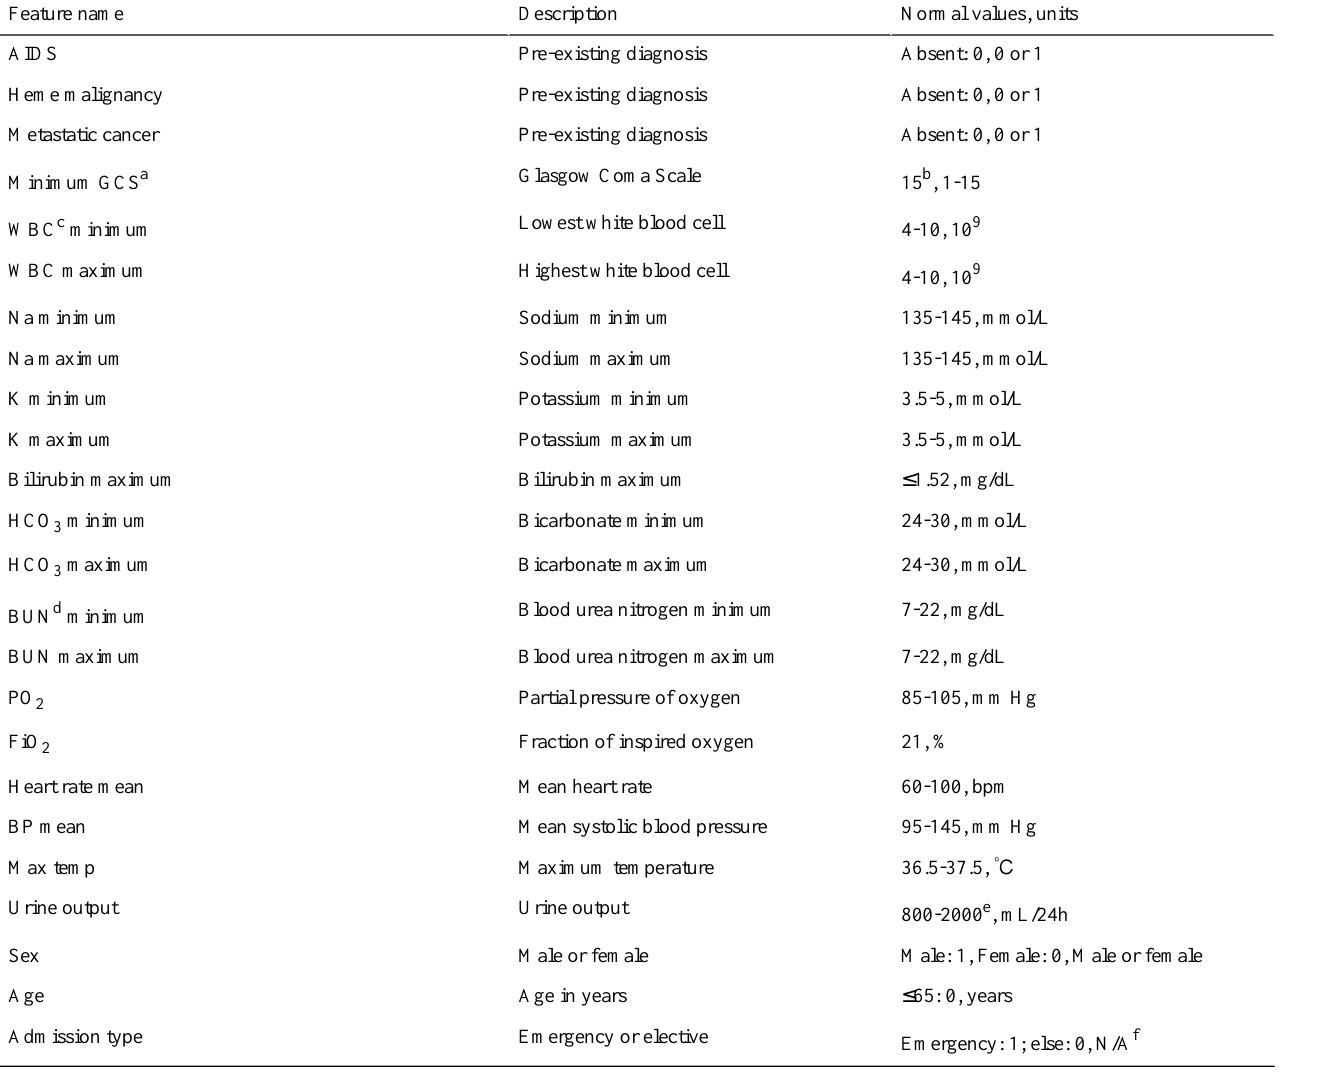
Table 1. Medical Information Mart for Intensive Care III variables based on Simplified Acute Physiology Score